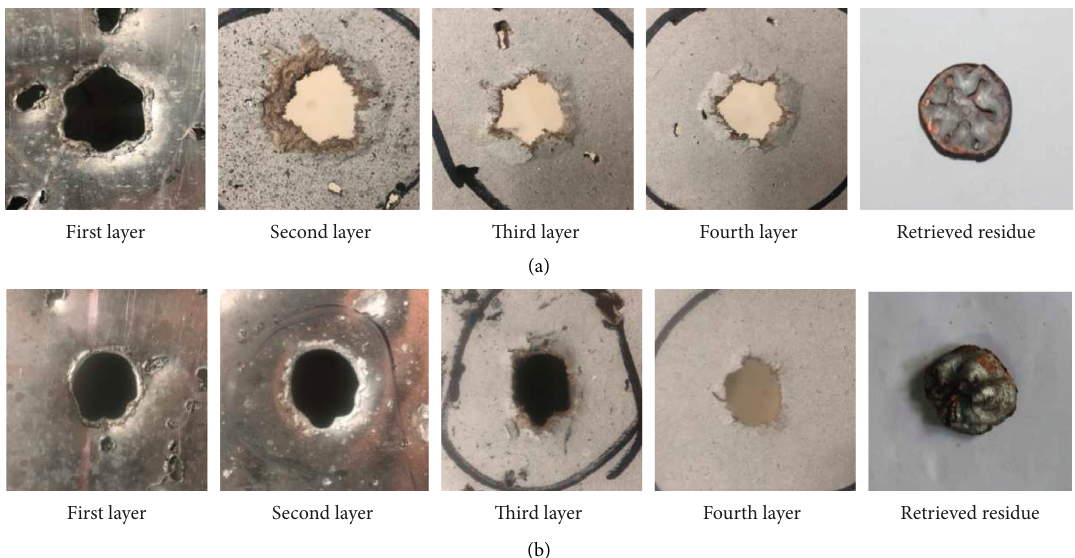
Figure 6: EFPs and perforation morphology residues for tests (a) A-1# and (b) A-4#.